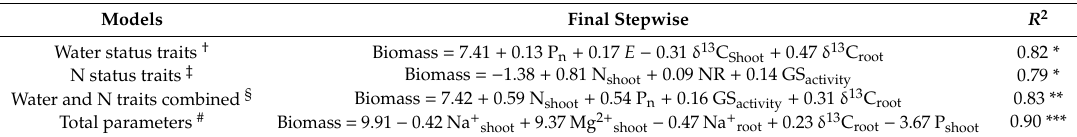
Table 6. Multiple linear regressions (stepwise) explaining biomass variation across genotypes and treatments based on water status-associated traits, N status-associated traits, the total traits, and the combination plus ion concentrations as independent variables. Levels of significant are as